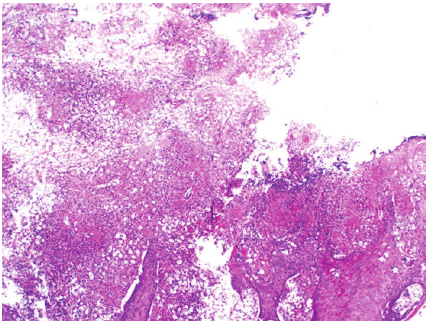
Figure 2: Low-power (40x) view of the lesion with surface ulceration, acute, and chronic